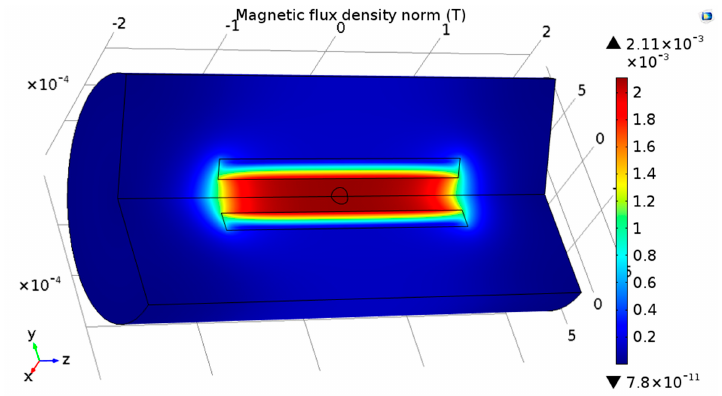
Figure 2. Magnetic field distribution within the sensor as influenced by the non-ferrous metallic particle.